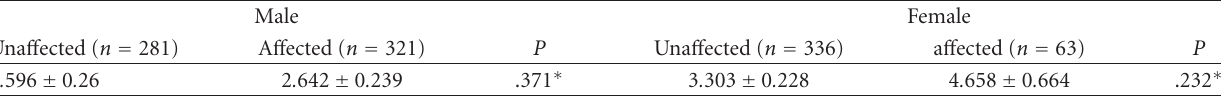
Table 2: Baseline high-sensitivity C-reactive protein (hsCRP) levels (mg/L).